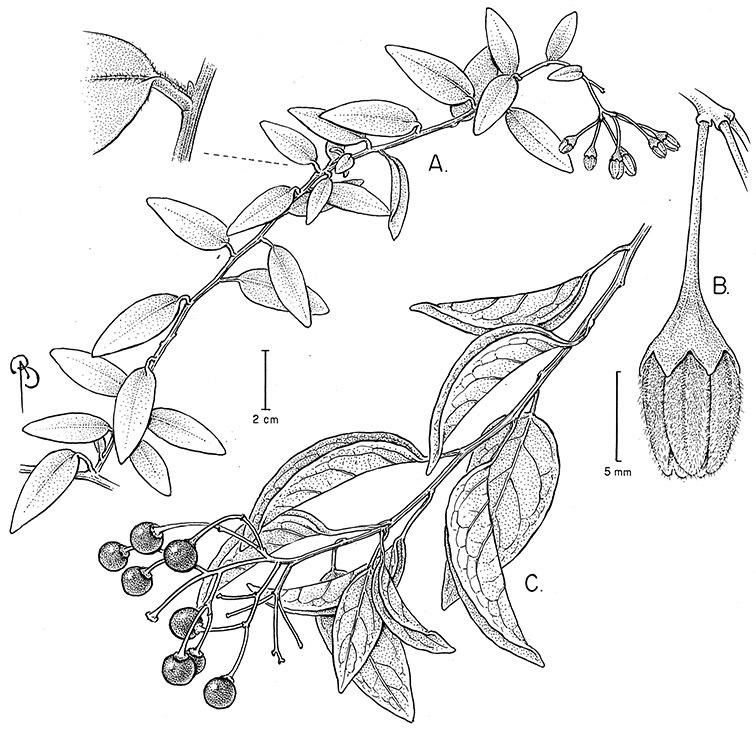
Solanum agnoston S.Knapp. (A, B drawn from Holm-Nielsen et al. 5115
C drawn from Jaramillo et al. 8832). Illustration by Bobbi Angell.